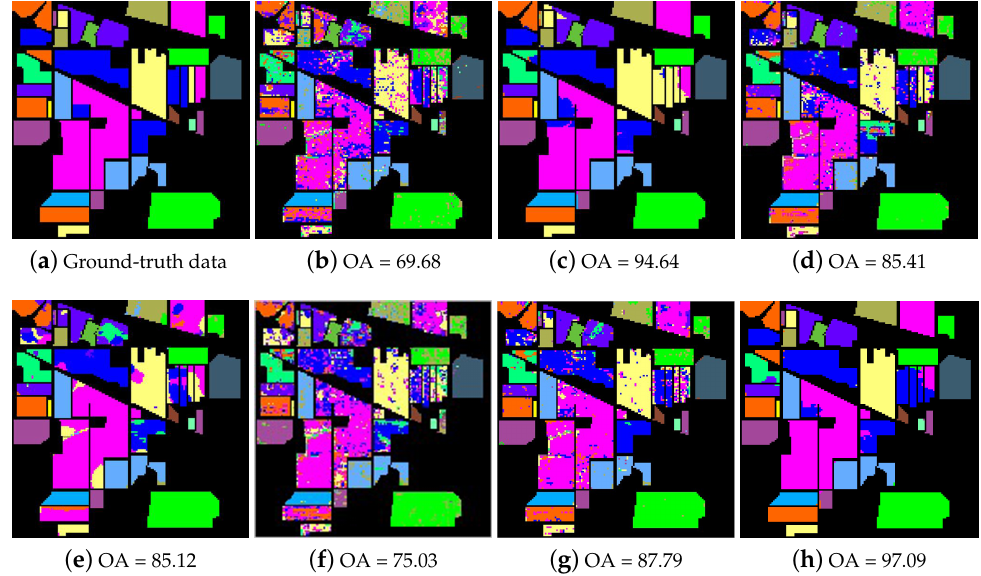
Figure 10. The classification maps of the different tested methods for the Indian Pines image. ( a ) ground-truth data; ( b ) SVM, support vector machine; ( c ) ERW, extended random walke; ( d ) SSLP-SVM, spatial-spectral label propagation based on SVM; ( e ) MPM-LBP, the maximizer of the posterior marginal by loopy belief propagation; ( f ) R-2D-CNN, recurrent 2D convolutional